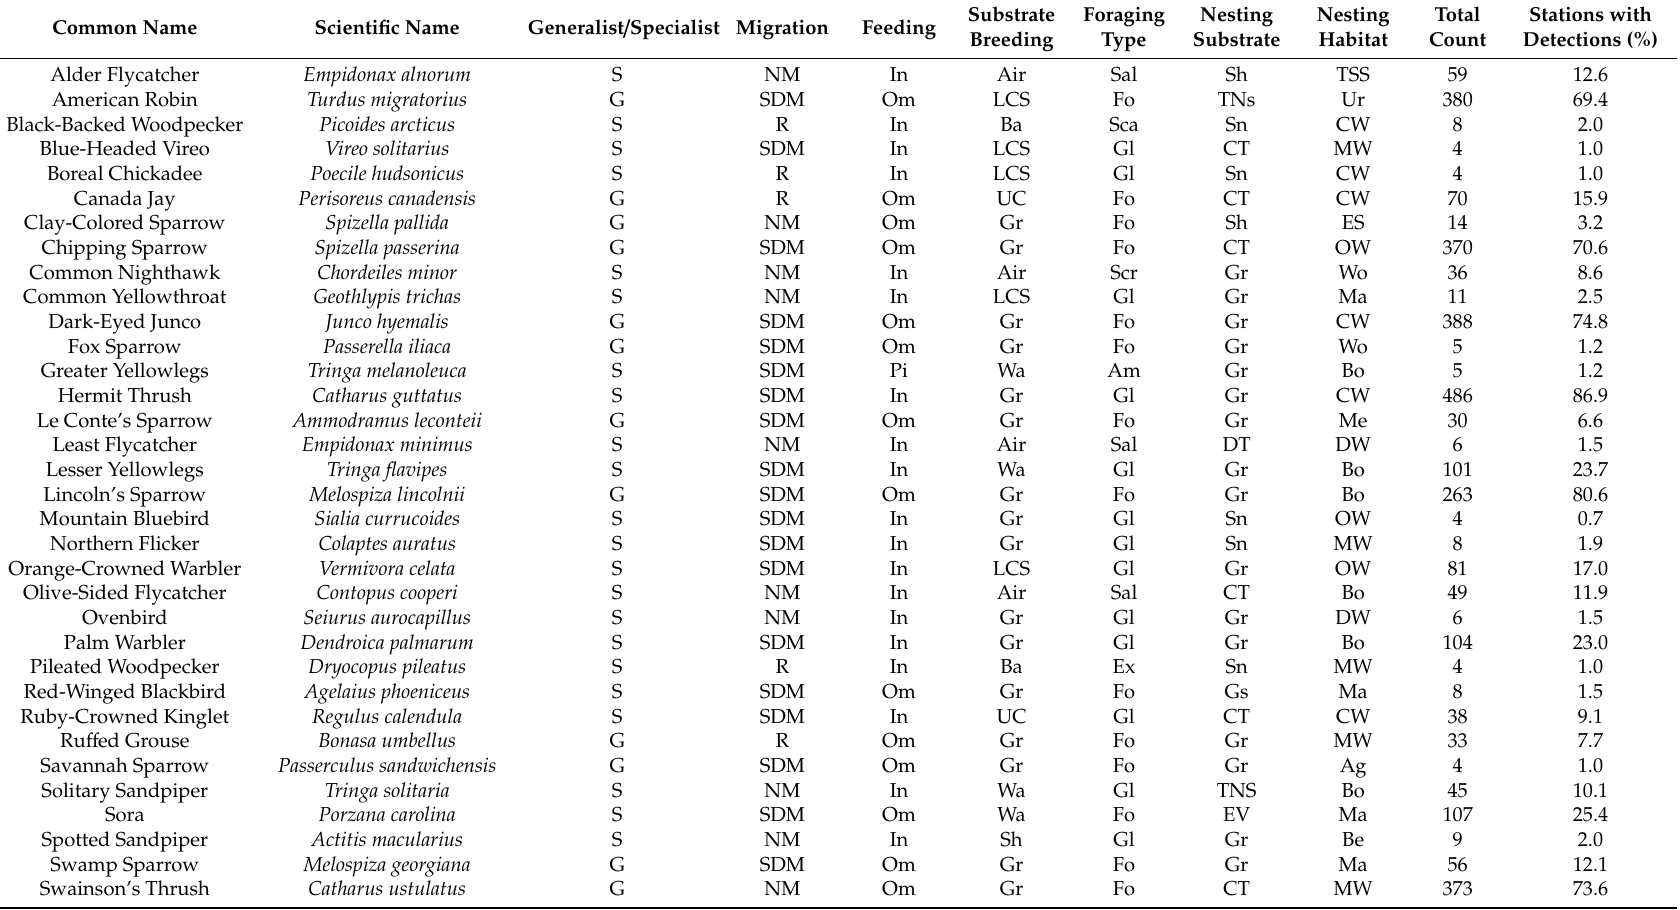
Table A1. Details of species detected in the study. Species detected at a minimum of three sampling stations in the study area, life history traits), the total number of individuals detected for both survey years (total count), and the percent of point count stations with detections for each